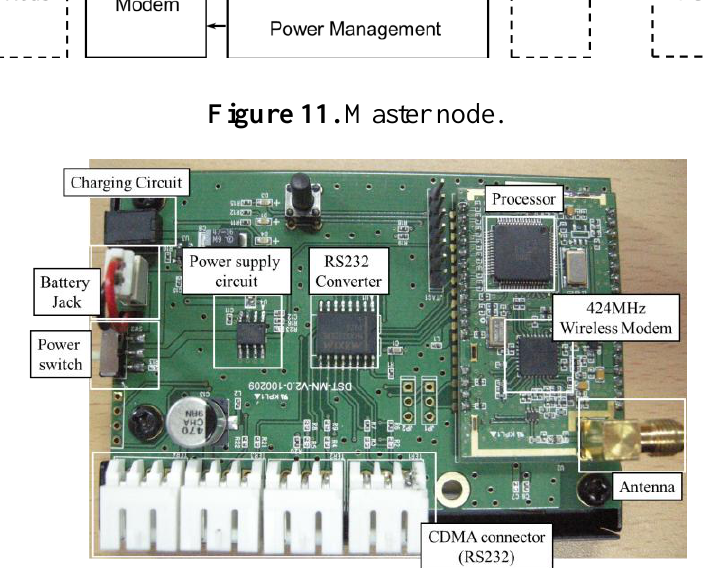
Figure 11. Master